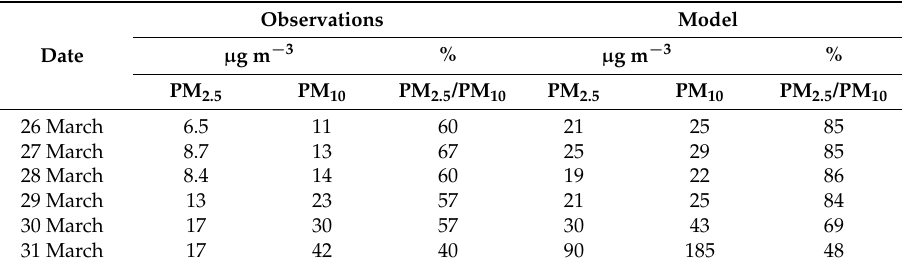
Table 2. Daily evolution end of March 2014 of observed and simulated concentrations at Billere (north of Pyrenees mountain range), the urban background station the closest to the Pyrenees with both PM 10 and PM 2.5 measurements.